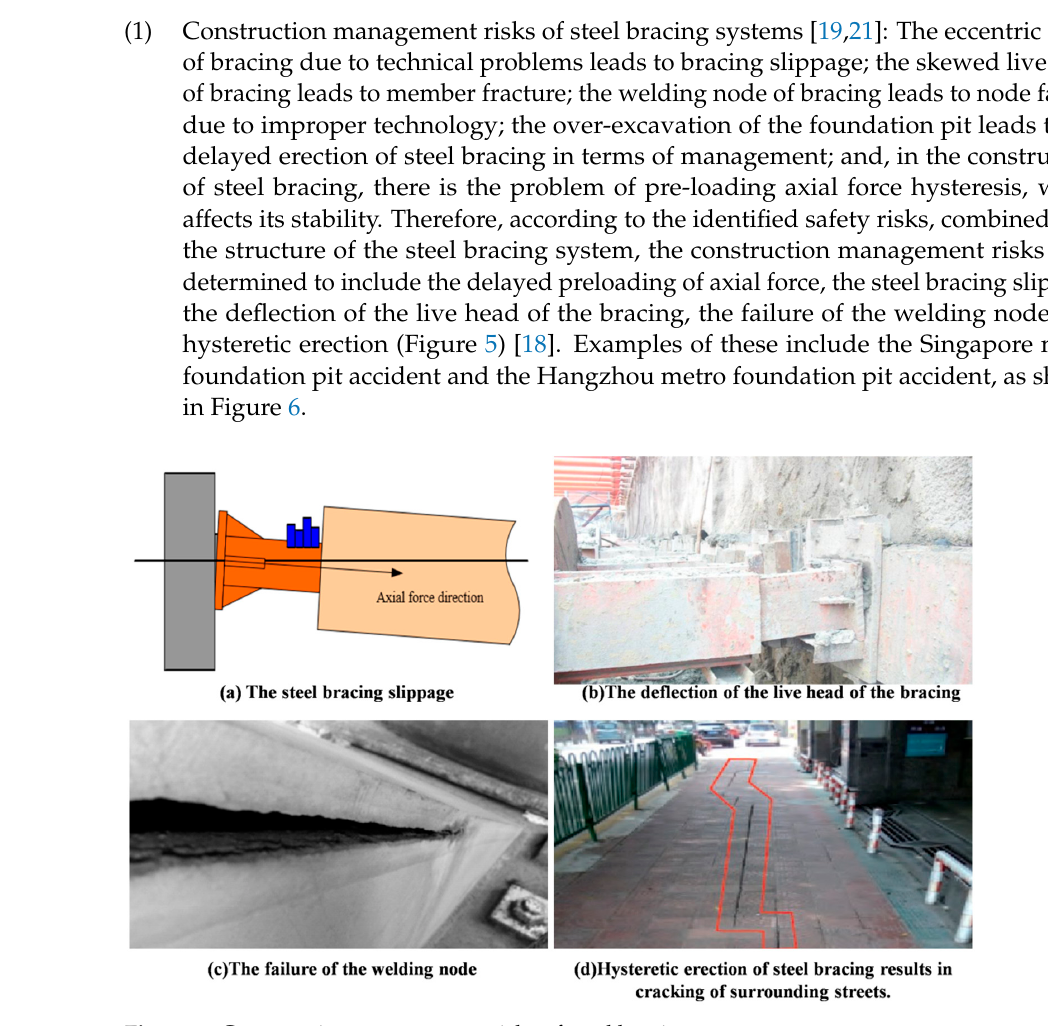
Figure 5. Construction management risks of steel bracing systems.